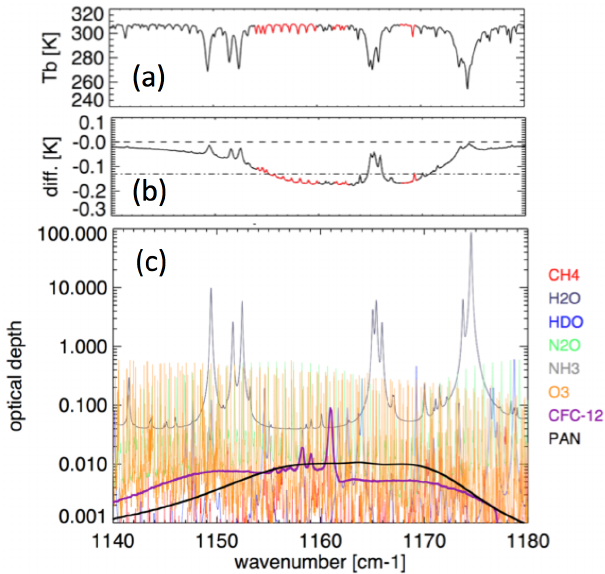
Figure 1. (a) Simulated TES spectrum in the PAN spectral region. Red regions show the spectral regions utilized in the TES PAN retrievals. (b) Brightness temperature difference for simulations with and without PAN, for the two PAN profiles shown in Figure 2 . (The signal for these two profiles cannot be distinguished by eye.) Dotted line shows the TES noise for a single observation. (c) Optical depth contributions for the dominant interfering species in this spectral region. Species other than PAN are for a US standard atmosphere.